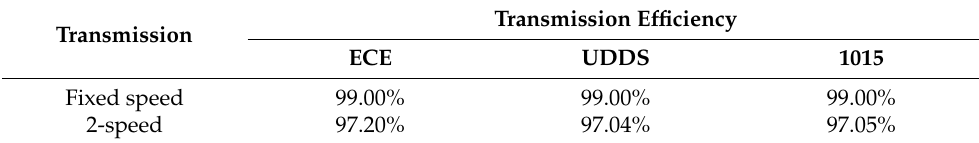
Table 3. Transmission efficiency comparison.